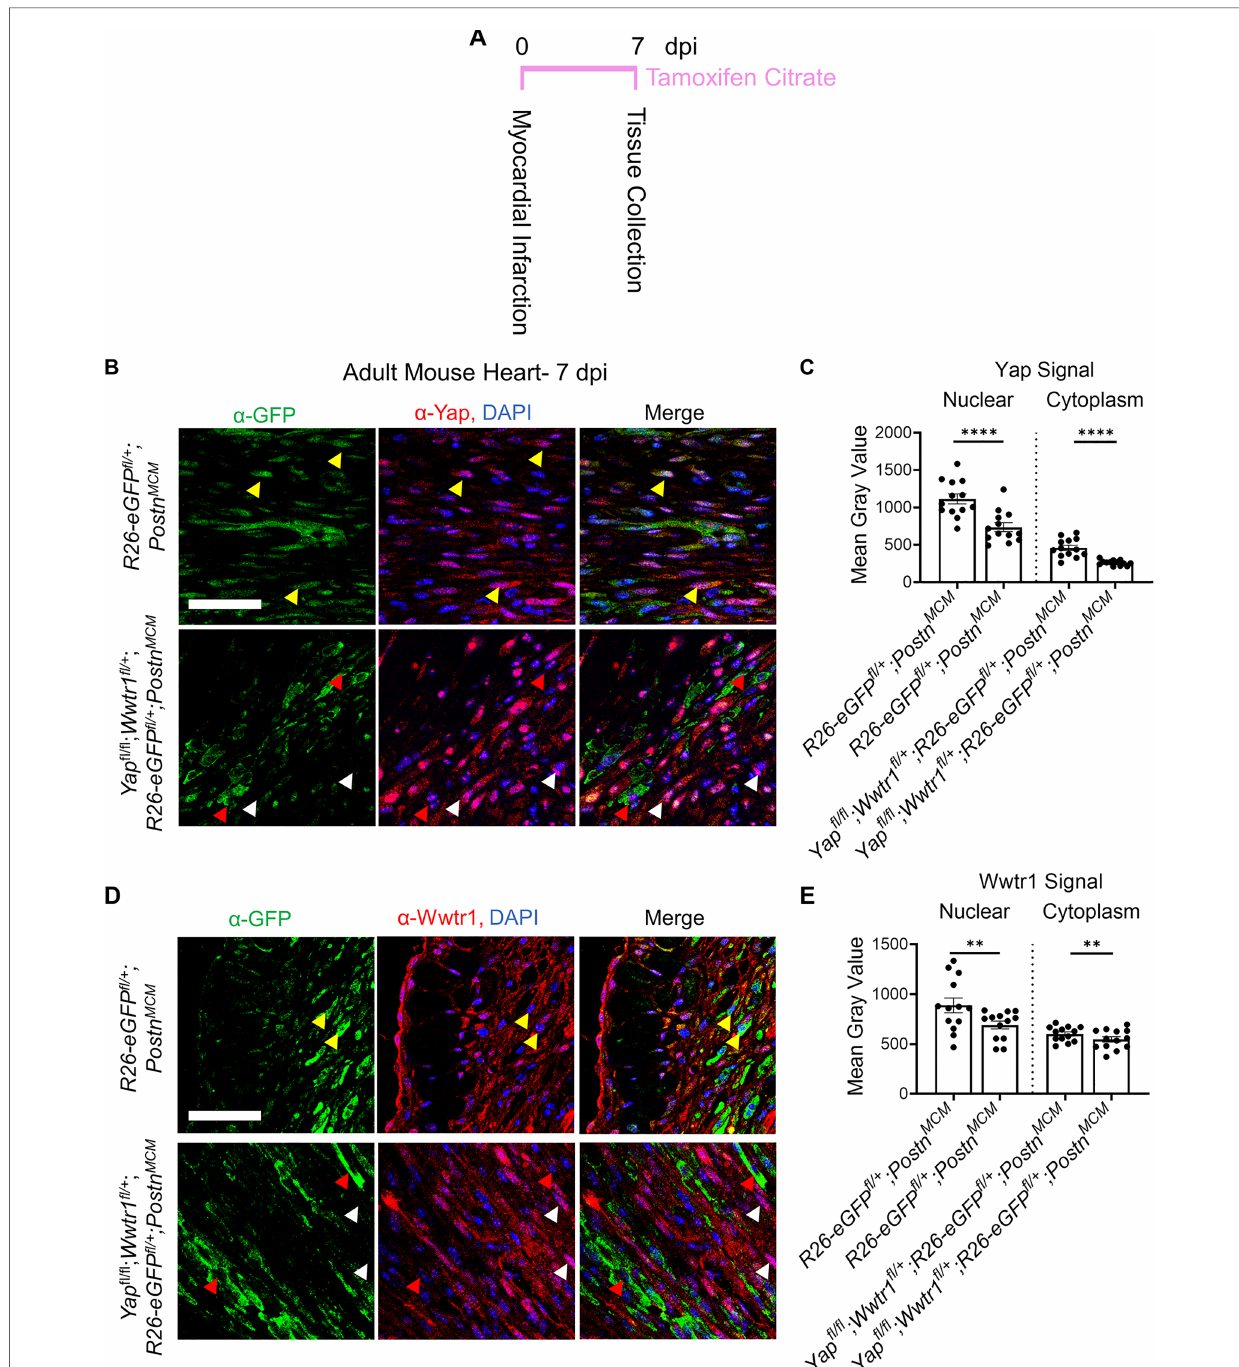
FIGURE 1 Yap and Wwtr1 expression is detected in myo fi broblasts after ischemic injury. ( A ) Experimental timeline of adult MIs and subsequent tamoxifen administration. ( B – E ) Representative confocal data of the scar region in R26-eGFP f/+ ;Postn MCM and Yap fl / fl ;Wwtr1 fl /+ ;R26-eGFP f/+ ; Postn MCM mice at 7 dpi. Scale=100 µm. ( B ) Immunostaining with α -GFP and α -Yap antibodies and DAPI. Yellow arrows denote Yap co-localization in GFP positive cells, red arrows denote absence of Yap colocalization in GFP positive cells, white arrows denote nuclear localized Yap in GFP negative cells. ( D ) Immunostaining with α -GFP and α -Wwtr1 antibodies and DAPI. Yellow arrows denote Wwtr1 co-localization in GFP positive cells, red arrows denote absence of Wwtr1 colocalization in GFP positive cells, white arrows denote nuclear localized Wwtr1 in GFP negative cells. ( C,E ) Quanti fi cation of Yap and Wwtr1 signal from histological staining in adult mice following MI. n =13 randomly selected GFP+cells. Unpaired student ’ s t -test with Welch ’ s correction. ** P <0.01. **** P